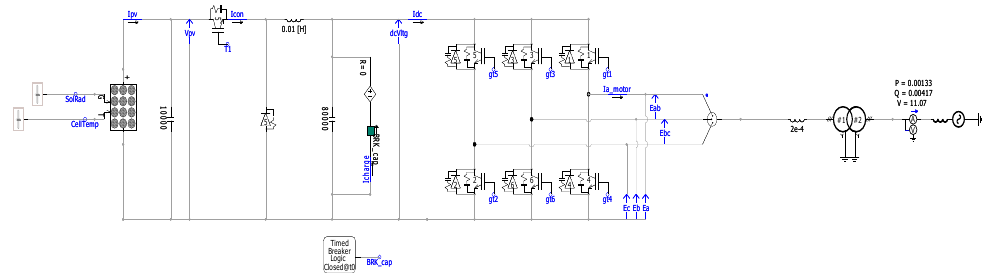
Figure 8. Photovoltaic power generation system simulation diagram.